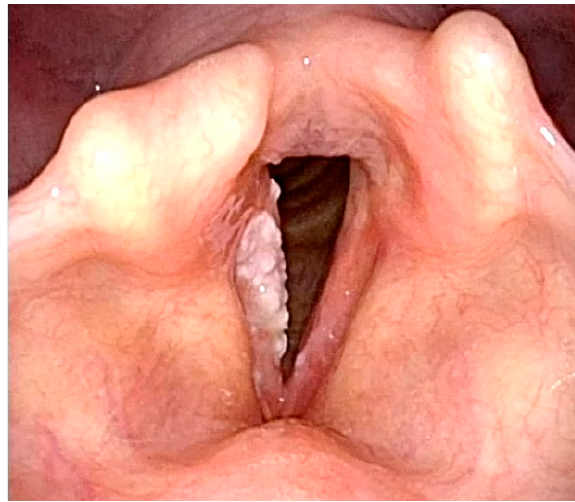
Figure 7. Histologically-verified squamous cell carcinoma of the right vocal cord presenting as leukoplakia. Young scoring system—5 points, Fang scoring system—5 points, Zhang type III—bulge and rough. Table 6. Laryngoscopic classification of vocal cord leukoplakia by Zhang et al. (2017) [17].